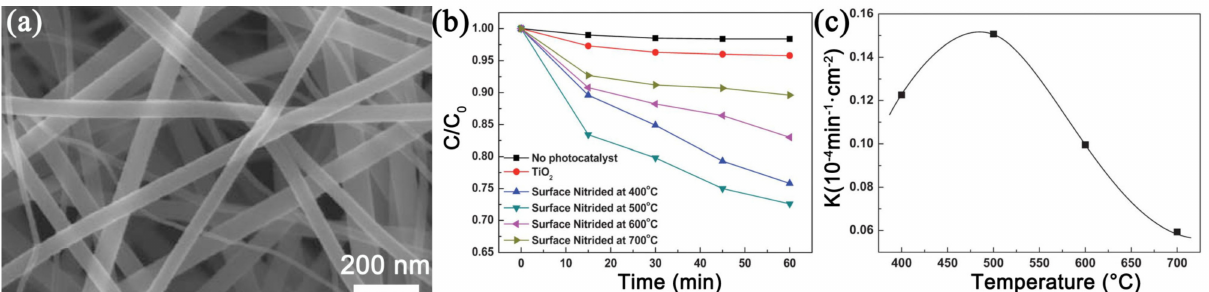
Figure 15. Morphology of N-TiO 2 nanofibers nitrided under NH 3 flow at 400 ◦ C for 4 h ( a ); visible-light photocatalytic activity of N-TiO 2 with different nitride temperatures ( b ); the relationship between the reaction rate constant and the nitride temperature ( c ). (Redrawn with the permission of Ref. [55]. Copyright 2012 The Royal Society of Chemistry).